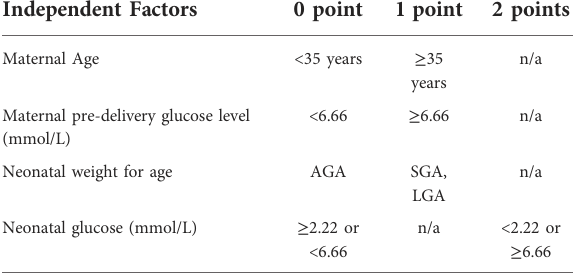
TABLE 1 Hypoglycemia risk score